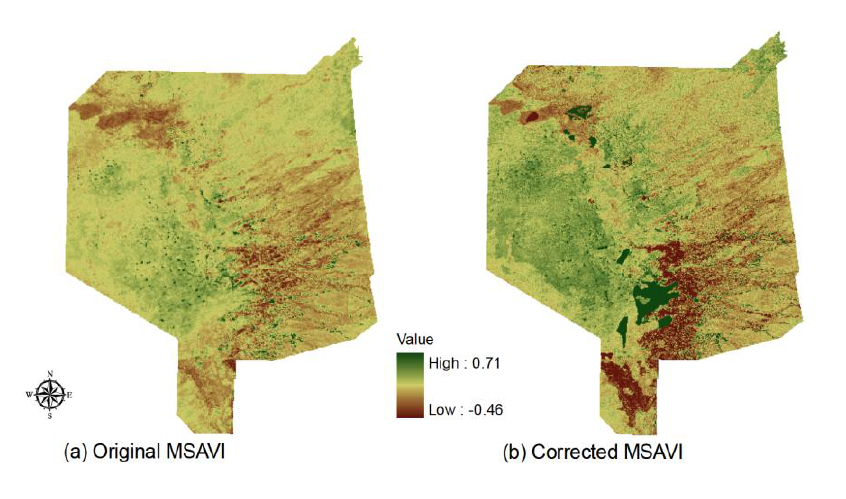
Figure 5. Comparison of MSAVI ( a ) before and ( b ) after reflectance